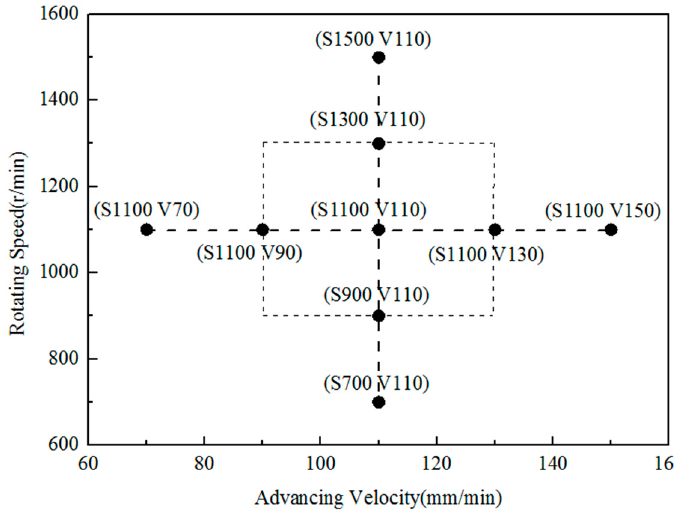
Figure 2. Set of process parameters adopted for FSCR (S-Rotating Speed, V-Advancing Velocity).